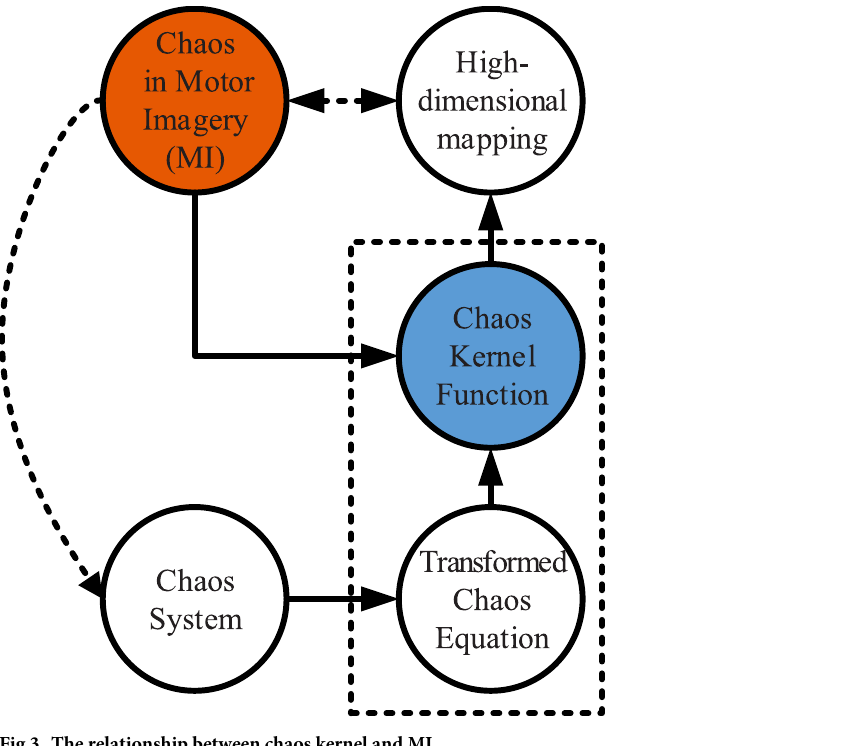
Fig 3. The relationship between chaos kernel and MI.